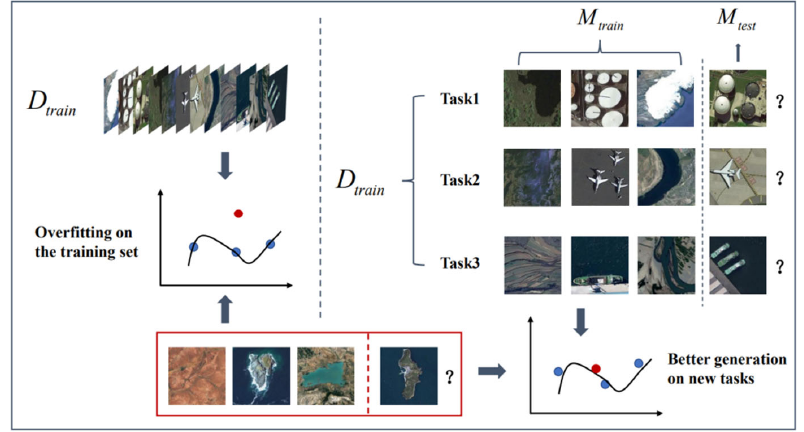
Figure 3. Comparison between traditional deep learning model training and meta training.